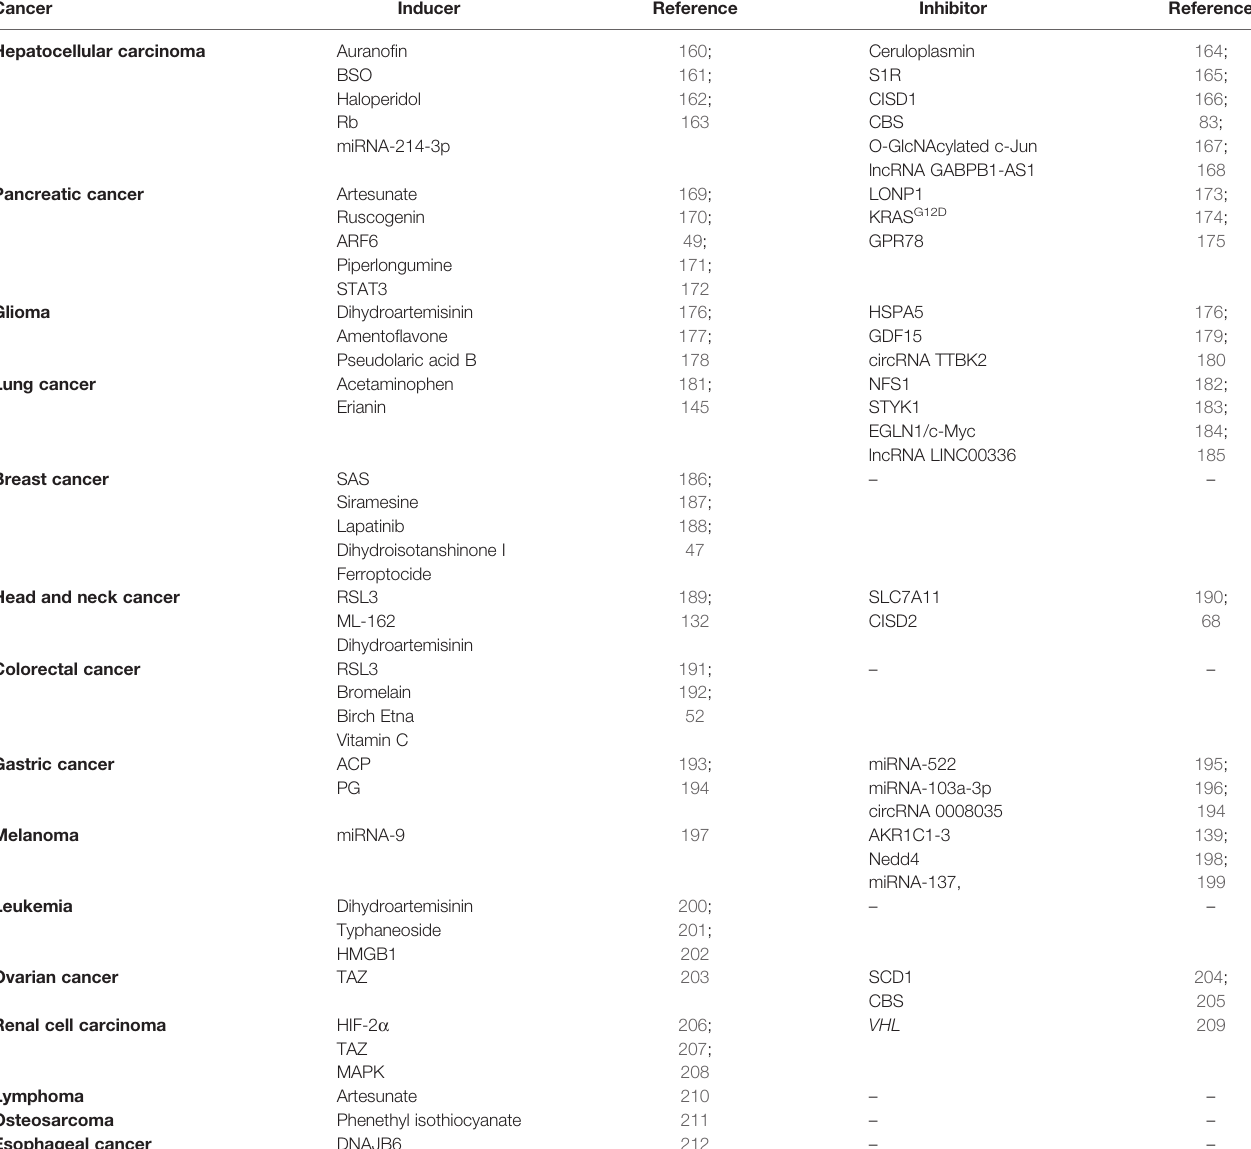
TABLE 2 | Inducers and inhibitors of ferroptosis in different